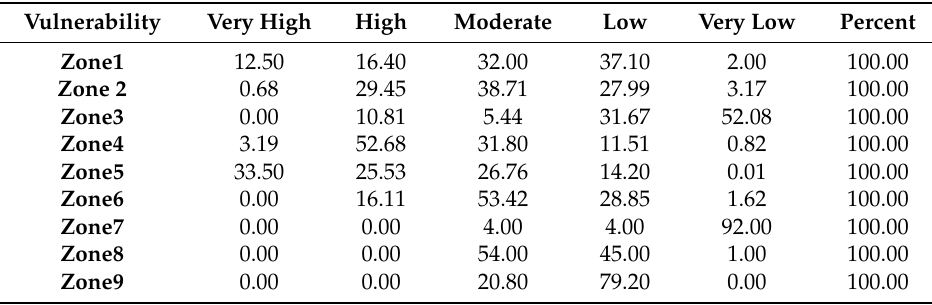
Table 12. Level of Residential Building Vulnerability (RBV) according to the proposed